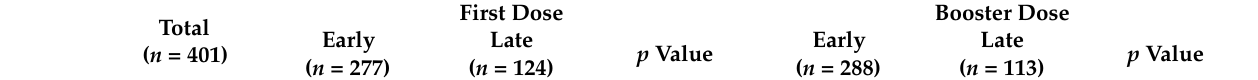
Table 2. Bivariate relationships between COVID-19 vaccine hesitancy and HL and trust # .